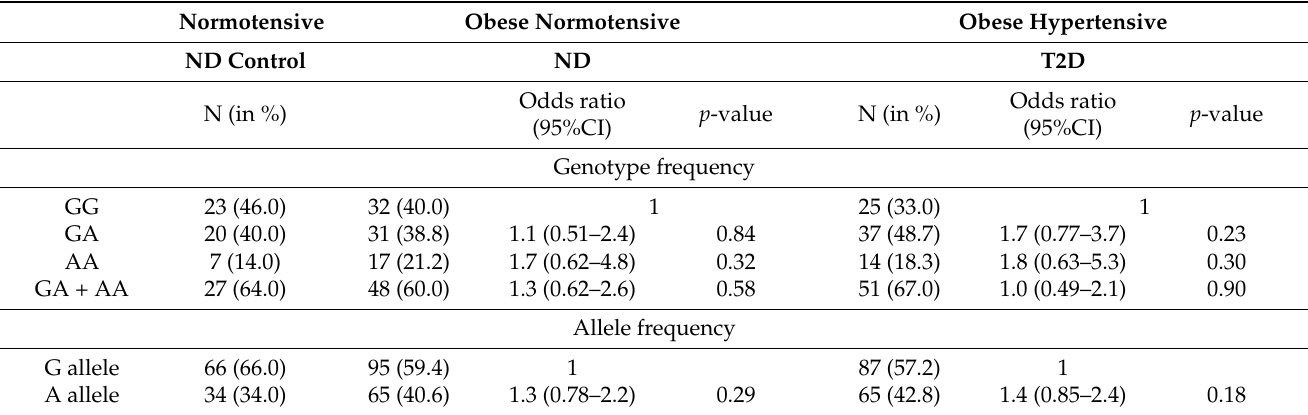
Table 2. Genotype and alleles frequency distribution of the -2548G/A LEP polymorphism.